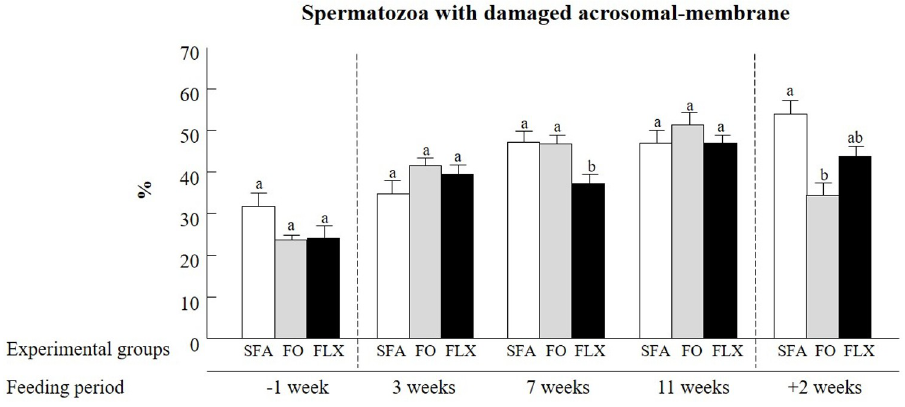
Fig 5. The effect of omega-3 sources flaxseed and fish oil on acrosomal membrane integrity. The proportions of spermatozoa exhibiting damaged acrosomal membrane, as determined by flow cytometer detection of the fluorescent probe FITC-PNA, are presented. The experimental groups were saturated fatty acid (SFA; control), fish oil (FO), and flaxseed oil (FLX). Ejaculates were collected before (-1 week), during (3, 7, and 11 weeks), and after (+2 weeks) the feeding trial. Data are presented as the mean ± SEM calculated for 5 replicates with 5000 spermatozoa for each replicate. Different letters above the columns indicate significant differences between experimental groups at each time point ( P < 0.05).